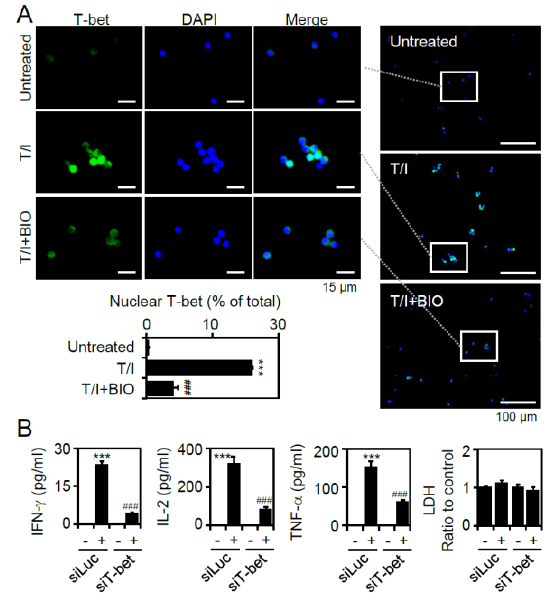
Figure 5. Pharmacological inhibition of GSK-3 β decreases the nuclear translocation of T-bet, which is required for controlling T lymphocyte cytokines. ( A ) Representative selected images of T-bet ( green ) immunostaining, which are obtained from the field of view (100 × total magnification), in Jurkat T cells pretreated with BIO for 0.5 h and then stimulated with T / I for an additional 6 h. DAPI ( blue ) was used for nuclear staining. The percentages of positive cells, which were calculated from three fields of view (100 × total magnification), are shown. ( B ) ELISA determined the levels of cytokines in the cell supernatants of T / I-treated Jurkat T cells transfected with siRNA targeting T-bet (siT-bet). siRNA targeting luciferase (siLuc) was used as a nonspecific control. For ELISA, an LDH assay was used to detect cell cytotoxicity, and the results are normalized to the untreated group. The data are shown as the mean ± SD from three individual experiments. *** p < 0.001 compared to the untreated cells. ### p < 0.001 compared to the T / I-treated group. ns, not significant.